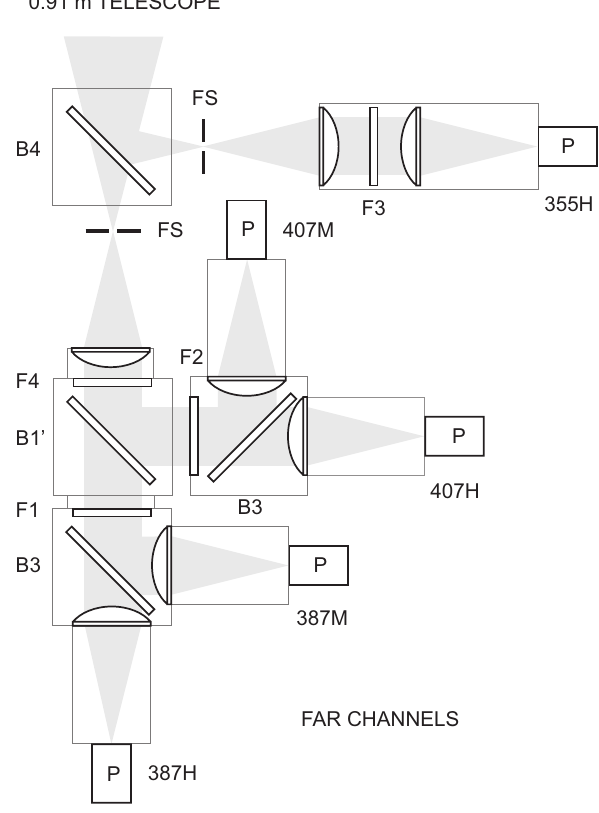
Fig. 11. TMW lidar receiver final configuration (2009–present) for the high- and mid-intensity